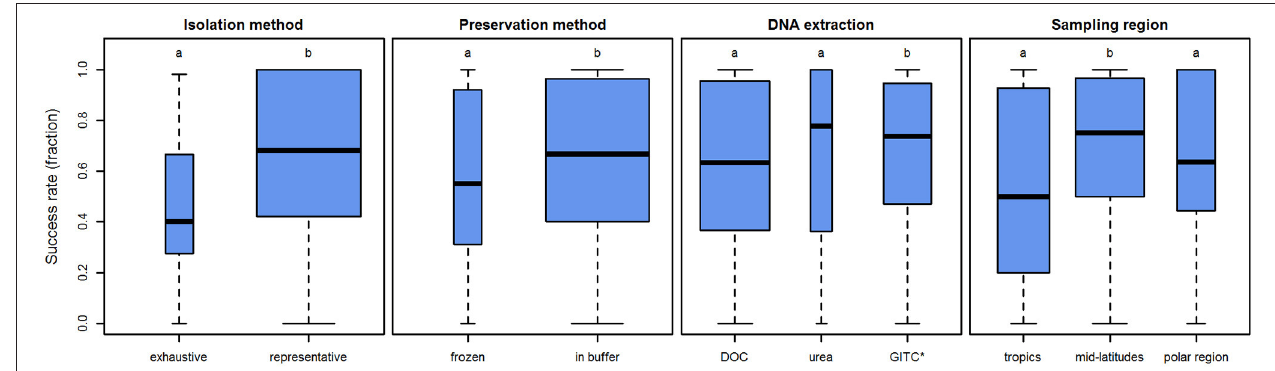
FIGURE 6 | Influence of several parameters on the amplification success rates in planktonic foraminifera. Boxplots showing the median (thick black lines), interquartile range (blue boxes), and 1.5 × interquartile range (whiskers) of the success rates in molecular analysis of planktonic foraminifera. Box width is scaled to the number of observations within the respective level. Lower case letters above boxes indicate groups between which success rates differ significantly.